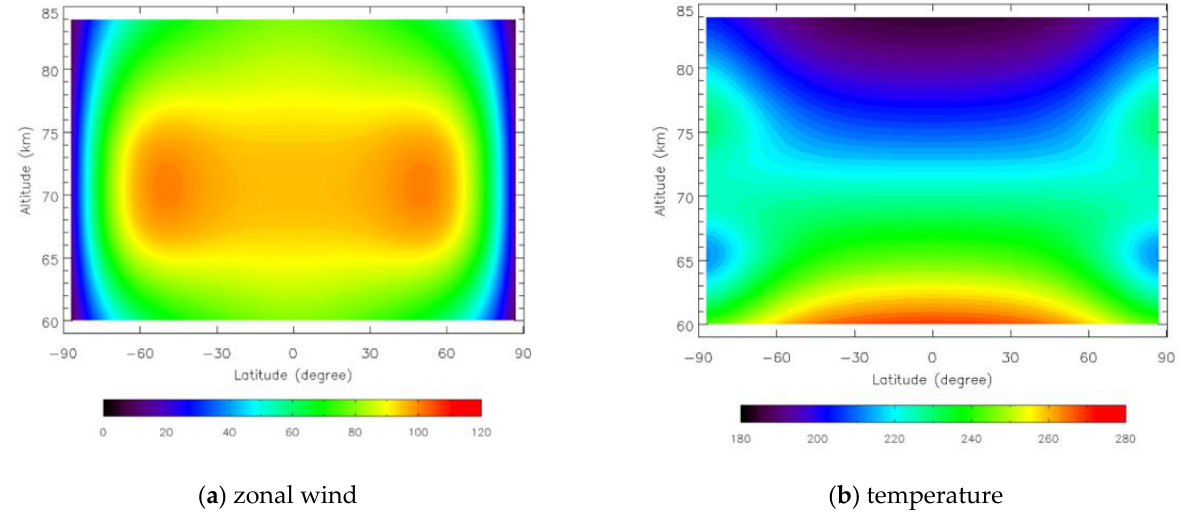
Figure A1. Latitude – altitude cross-sections of ( a ) zonally averaged zonal wind (m/s) and ( b ) temperature (K) in the linear wave propagating model [15,16] used for producing synthetic observations.